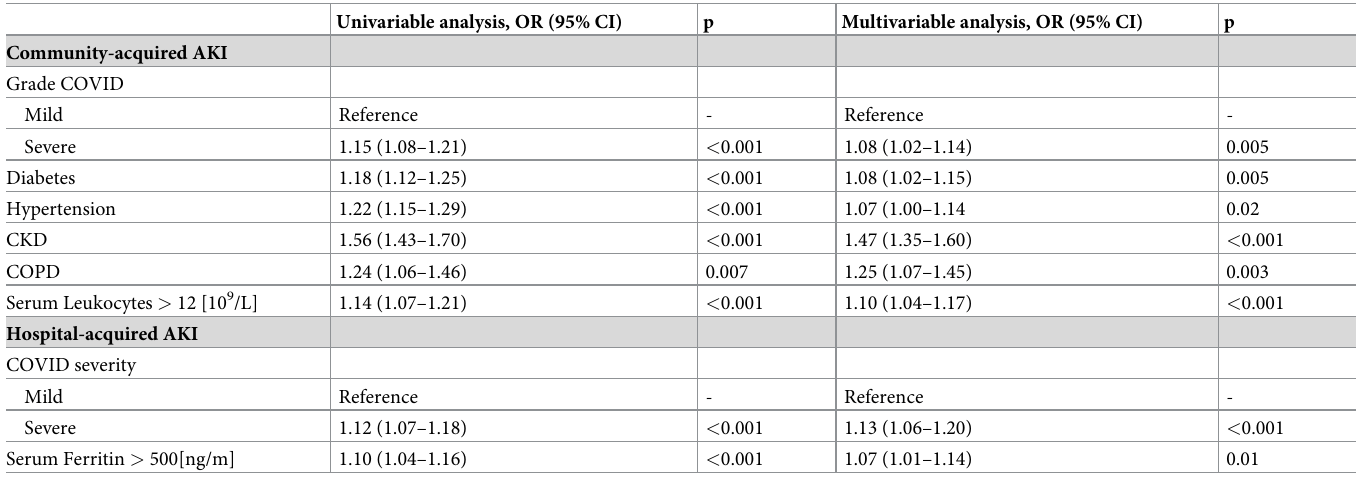
Table 4. Factors associated with CA-AKI and HA-AKI in hospitalized COVID patients, in the univariable and multivariable logistic regression model. Univariable analysis, OR (95%